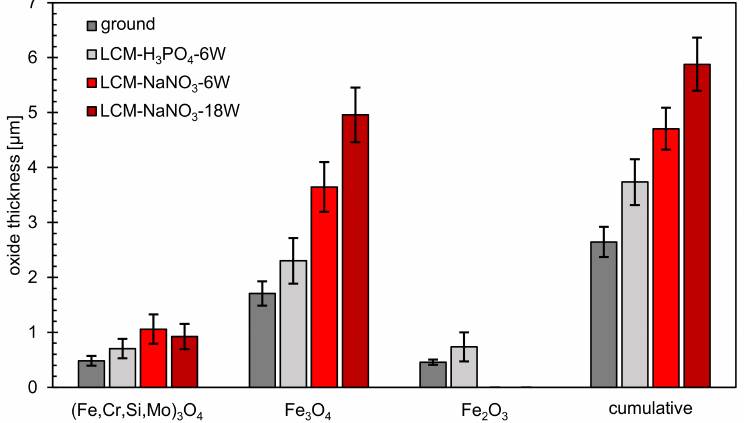
Figure 12. Thickness of oxide layers after oxidation at 500 ◦ C for 20